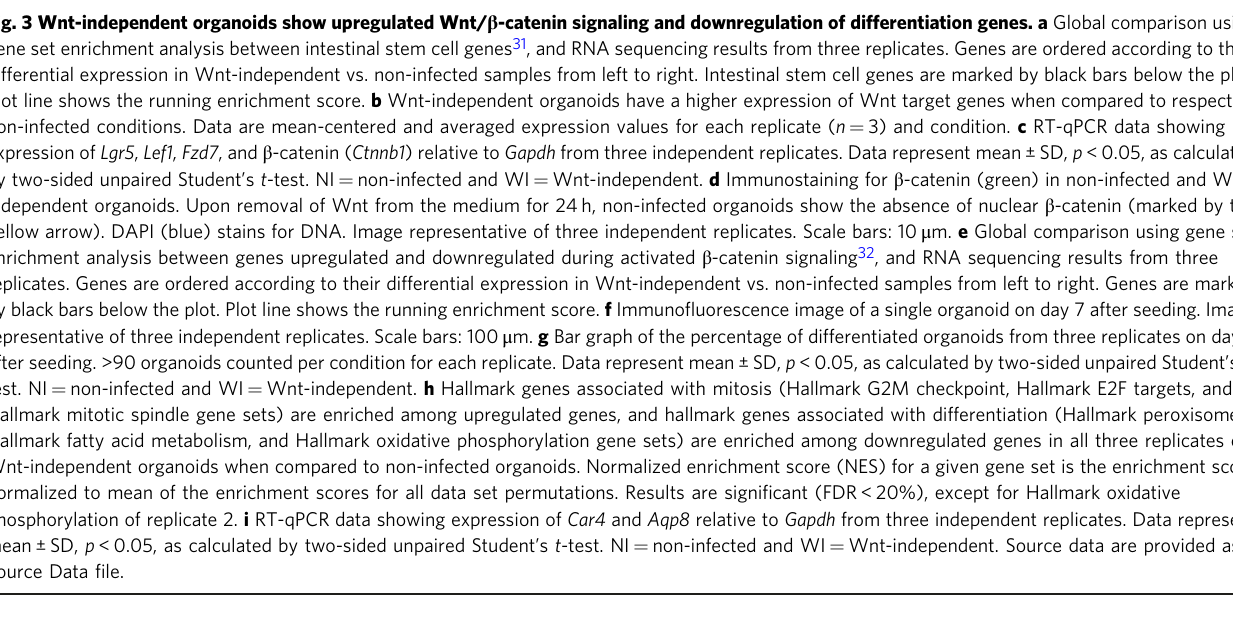
(Fig. 3h). In addition, the enterocyte-speci fi c differentiation genes carbonic anhydrase 4 ( Car4 ) and aquaporin 8 ( Aqp8 ) were downregulated in Wnt-independent organoids (Fig. 3i). Thus, infection-induced Wnt-independence of organoids was accom- panied by a proliferative cell phenotype and impaired differentiation.